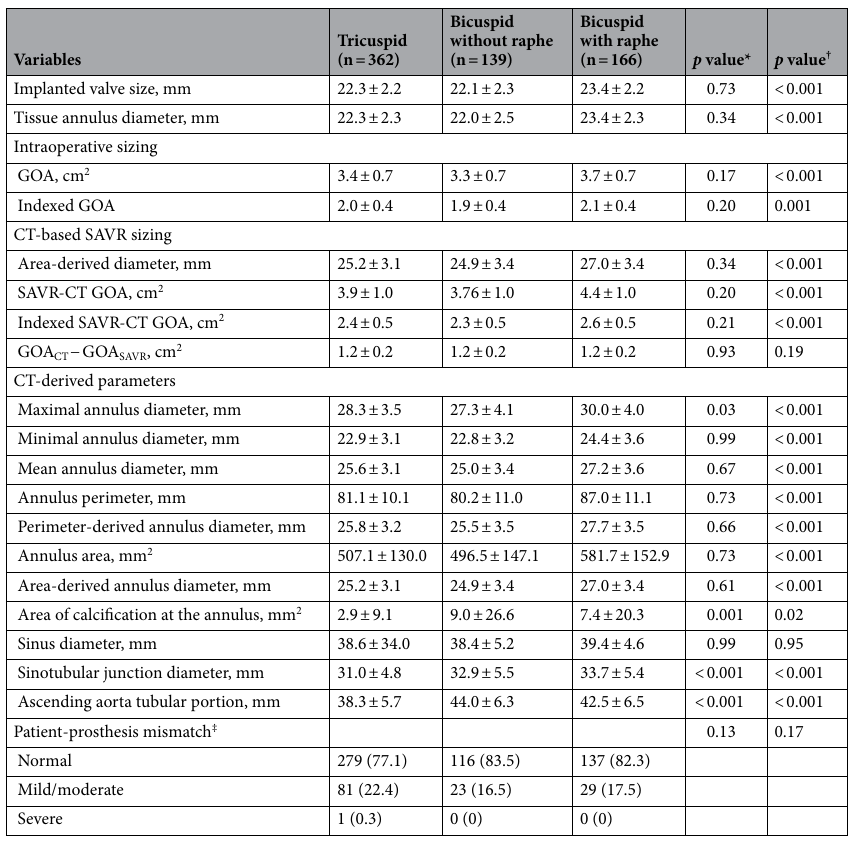
Table 2. Surgical aortic valve size and CT measurements. Data are shown as the number of patients with percentages in parentheses or mean ± standard deviation. GOA, geometric orifice area; SAVR, surgical aortic valve replacement. * p values are obtained by comparing between tricuspid and bicuspid without raphe and † between tricuspid and bicuspid with raphe. ‡ p values are obtained by comparing between normal group and the group with mild to severe grade of patient-prosthesis mismatch.